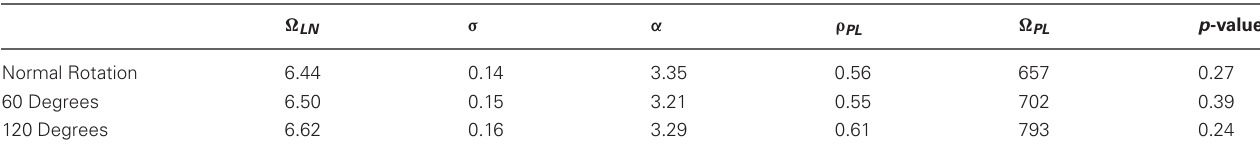
Table 2 | Cocktail parameters corresponding to the three example empirical response time distributions taken from a letter rotation task in Figure